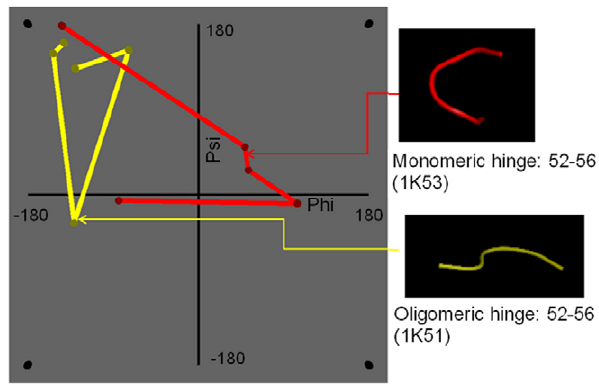
Figure 7. ( Q , y ) conformation of reverse loop monomeric hinge and extended loop oligomeric hinge in protein with inset showing ribbon representation of the actual crystal structures.